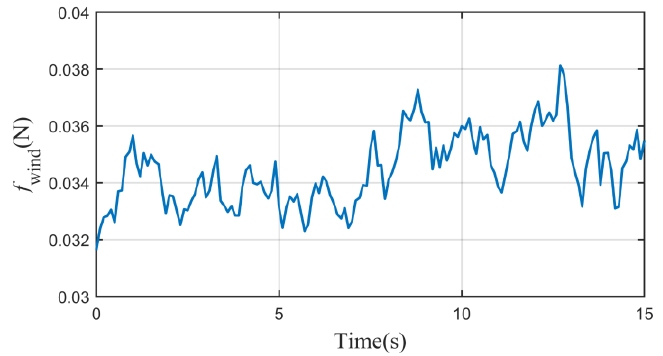
Figure 8. Simulated wind disturbance.